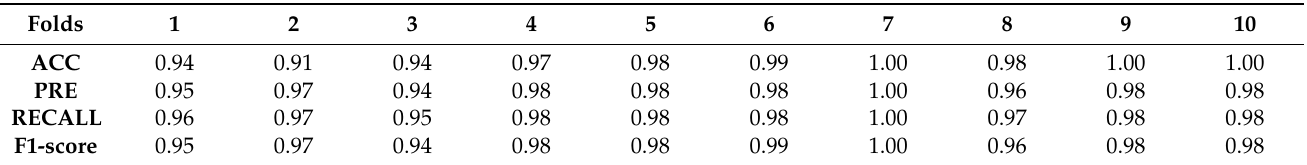
Table 6. Comparison of proposed work with some standard models and other existing models. Ref.